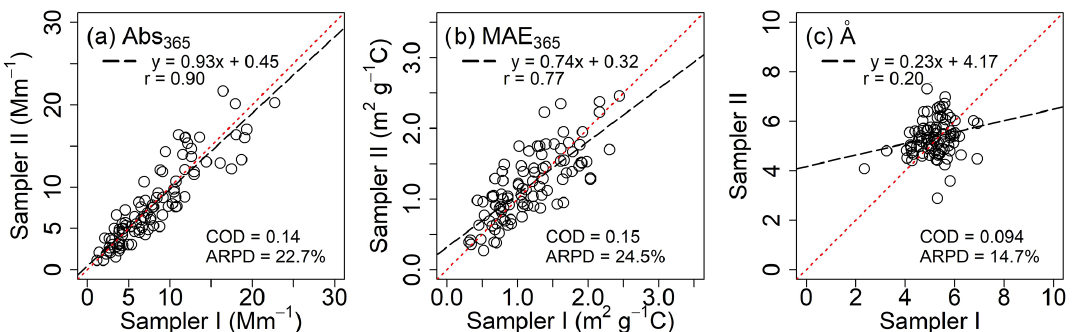
Figure 1. Comparisons between collocated measurements for light-absorbing properties of PM 2 . 5 extracts in DMF after Q b